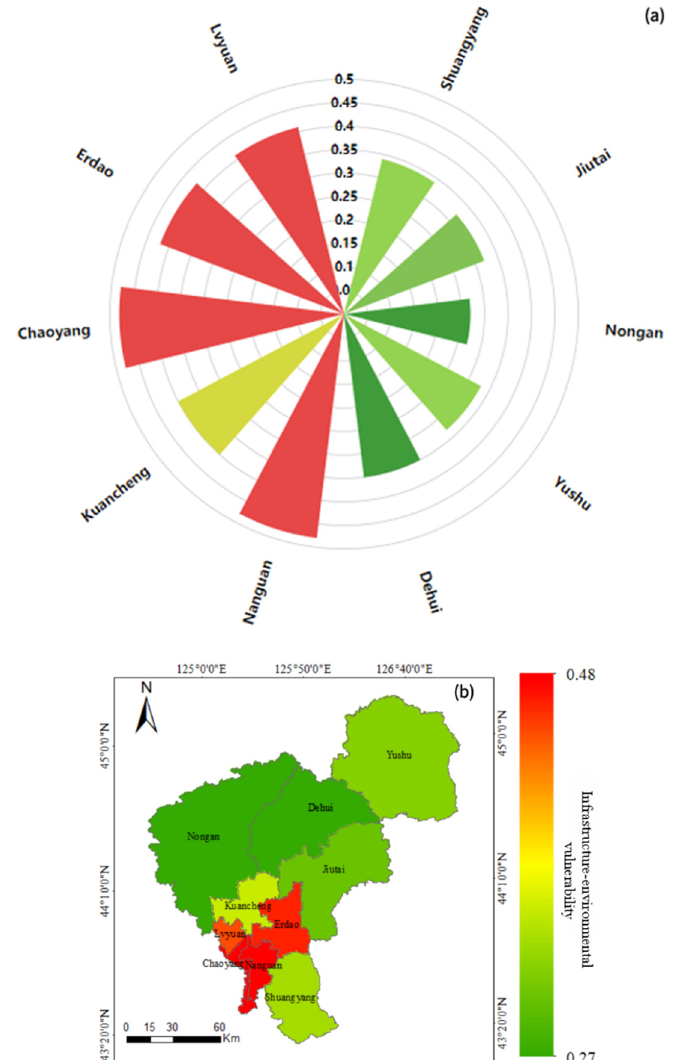
Figure 4. Infrastructure and environmental vulnerability map: vulnerability value ( a ); spatial distri- bution of vulnerability ( b